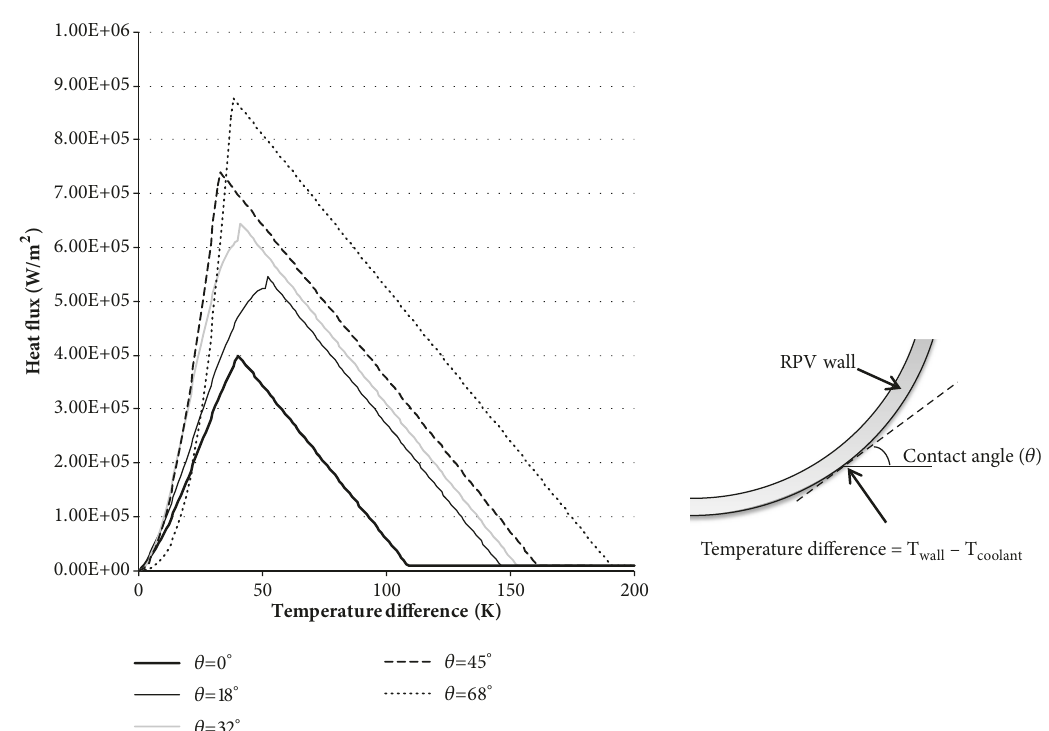
Figure 2: Heat flux as a function of temperature difference and contact angle for COUPLE heat transfer under saturated boiling conditions [10].